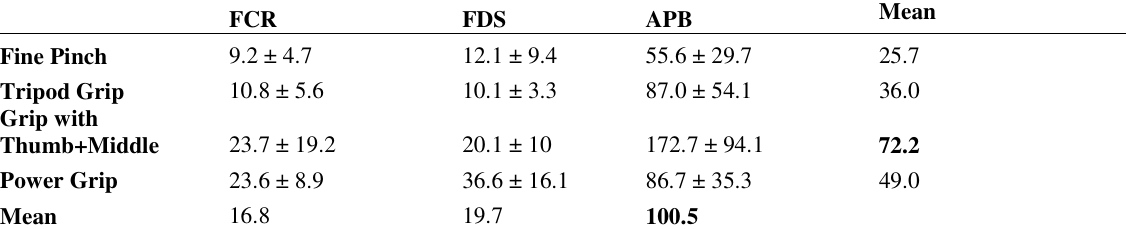
Mean values of EMG activity (mean ± SD) in in ( µ V) of different grips types for the case of 50% MVC for 5 subjects for FCR, FDS and APB muscles.